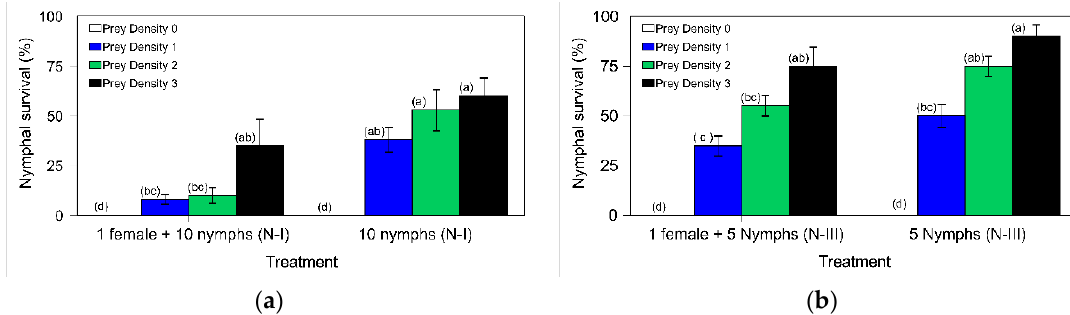
Figure 5. Survival (%) (±SE) of the Nabis pseudoferus instars: ( a ) N ‐ I to N ‐ III) or ( b ) N ‐ III to adult in the presence or absence of an adult female, according to the prey density. The microcosm trial was performed using tomato plants under laboratory conditions (25 ± 2 °C and 60%–80% RH). In each figure: the values with di ff erent superscript letters (a, b, c, and d) in a column are significantly di ff erent ( p <